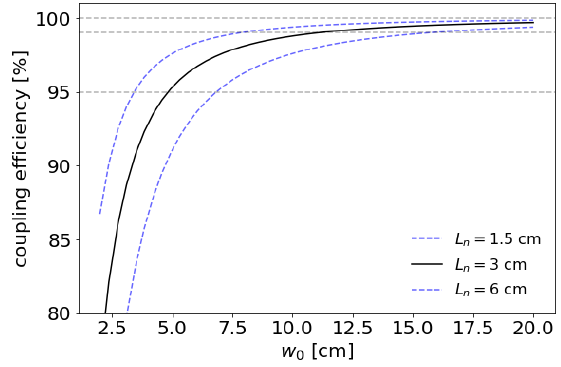
Fig. 8 : The transmission coefficient as a function of the beam waist size. Larger beams have lower divergence and thus more efficient